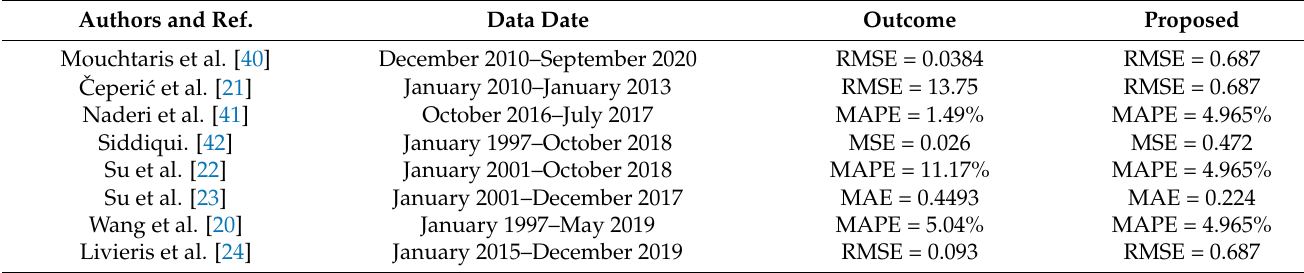
Table 4. Prediction errors from current gas price forecast